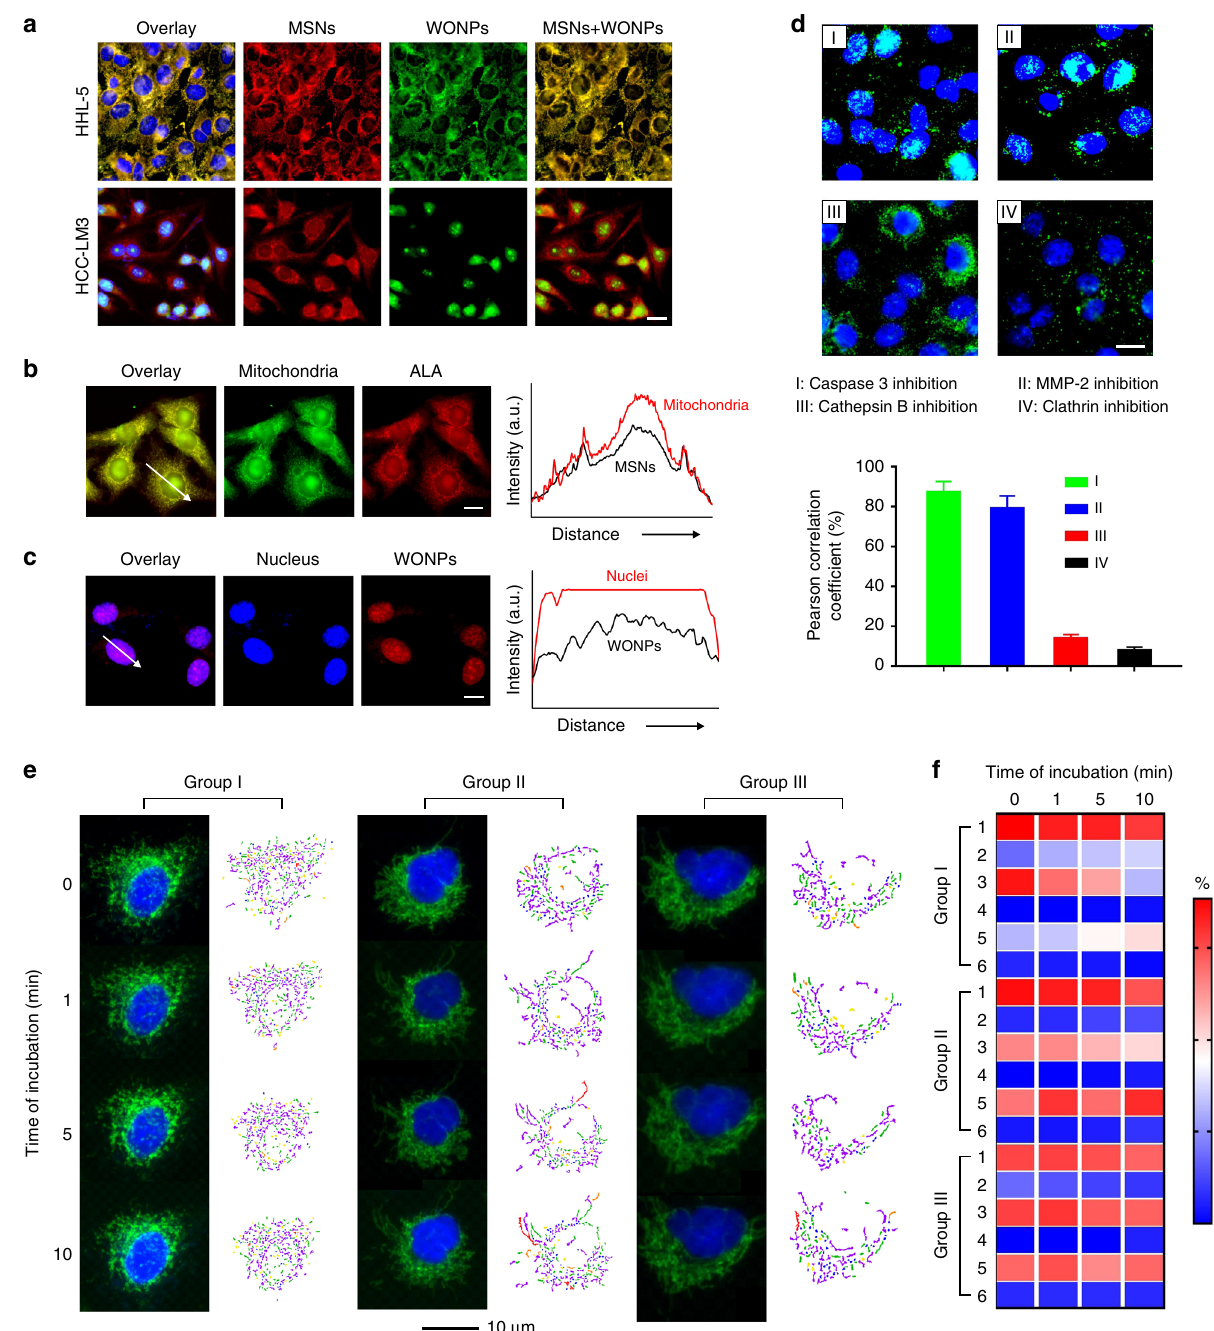
Fig. 3 In vitro cellular uptake and targeting. a The fl uorescence micrographs of HHL-5 (hepatocyte) and HCT-116 (cancer cell) cells post incubation with Mito(T)-pep-Nuc(T)(Alex Fluor-488-labeled) for 4 h. The nuclei of the cells were stained with Hoechst after the incubation with nanoparticles. Scale bar: 10 μ m. b , c Correlation of b Mito(T)-pep-Nuc(T)(no labeling) with mitochondria (stained with Mitotracker Green) and c Mito(T)(no payload)-pep-Nuc(T) (dye-labeled) and nuclei (stained with Hoechst) post a 4 h incubation with HCT-116 cells. Their fl uorescence intensity pro fi les were measured using Fiji (Image J) and shown as a function of distance on the right. d the correlation of dye-labeled Nuc(T) with nuclei post a 4 h incubation of Mito(T)-pep-Nuc(T) with HCT-116 cells whose activity of Caspase 3, MMP-2, Cathepsin B, or Clathrin was blocked. Scale bar: 10 μ m. The Pearson correlation analyses of the fl uorescence micrographs were shown at the bottom (data are presented as mean ± s.e.m., n = 4). e In situ time-lapse fl uorescence study of the changes in mitochondrial morphology during laser irradiation (633 nm, 1 W cm − 2 ). The HCT-116 cells were pre-incubated with Mito(T)-pep-Nuc(T). The observation was conducted in triplicate as denoted by Group I – III, with the microstructures of mitochondria analyzed using MicroP software, including six classes of mitochondria as detailed in the captions (I – VI). f The populations of six phenotype mitochondria as a function of the duration of laser irradiation. A color bar on the right indicates the color scales. P values were calculated using one-Way ANOVA (*** p <